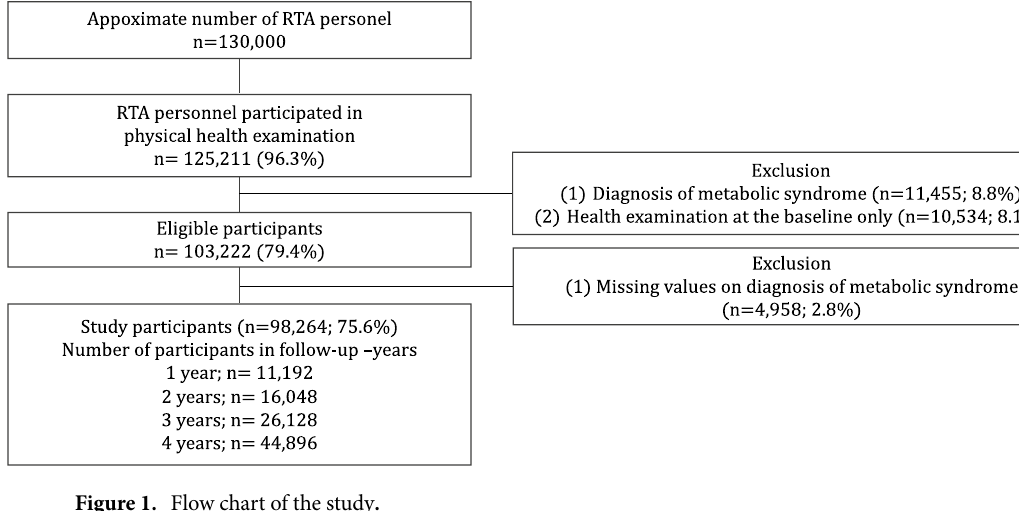
Figure 1. Flow chart of the study